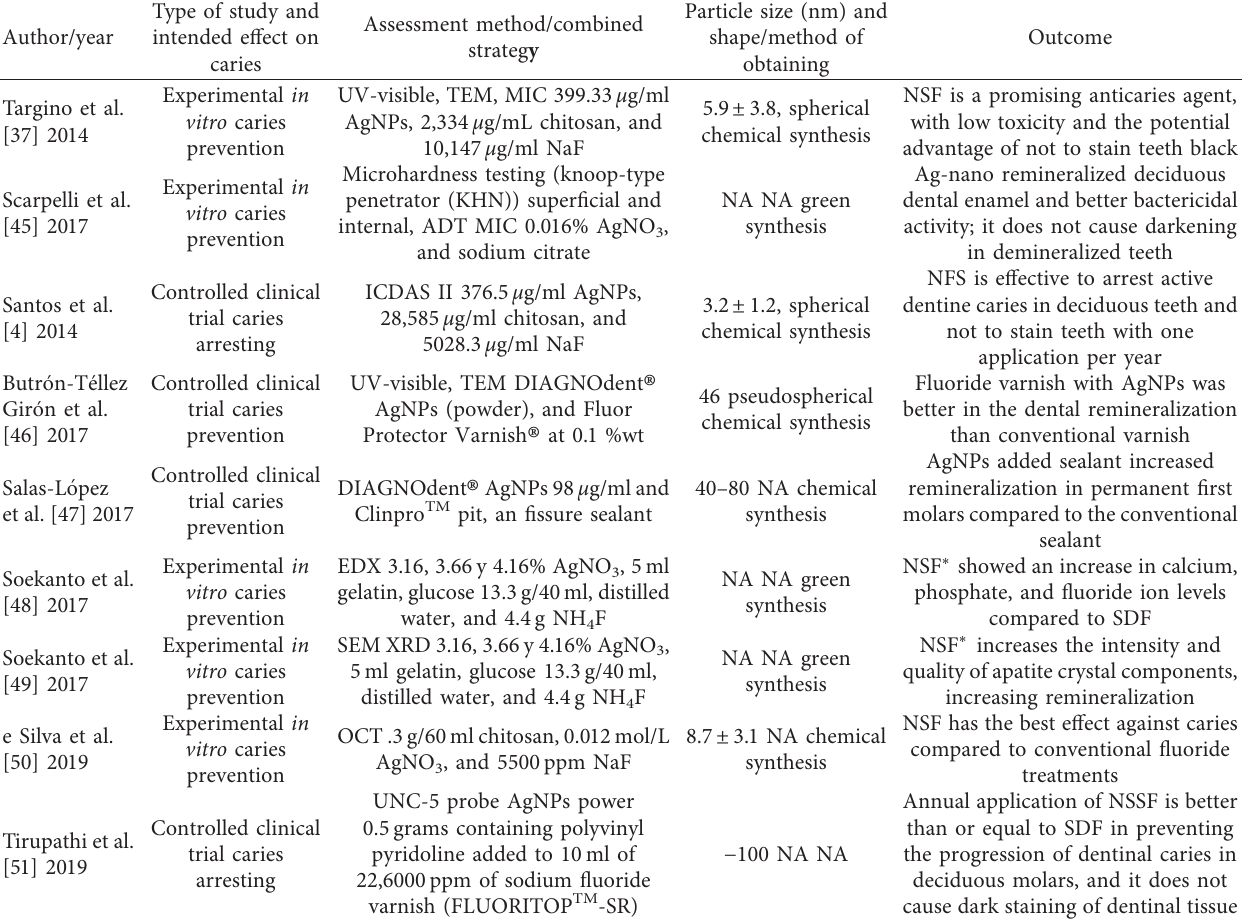
Table 1: Use of silver nanoparticles in the prevention and arrest of the dental